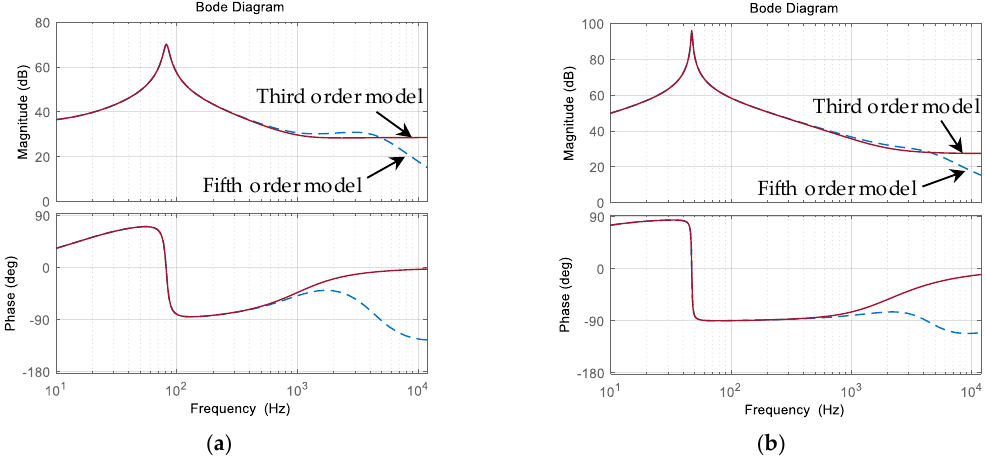
Figure 5. Frequency responses of the third- and the fifth-order RC damped models: ( a ) Buck mode; ( b ) Boost mode.